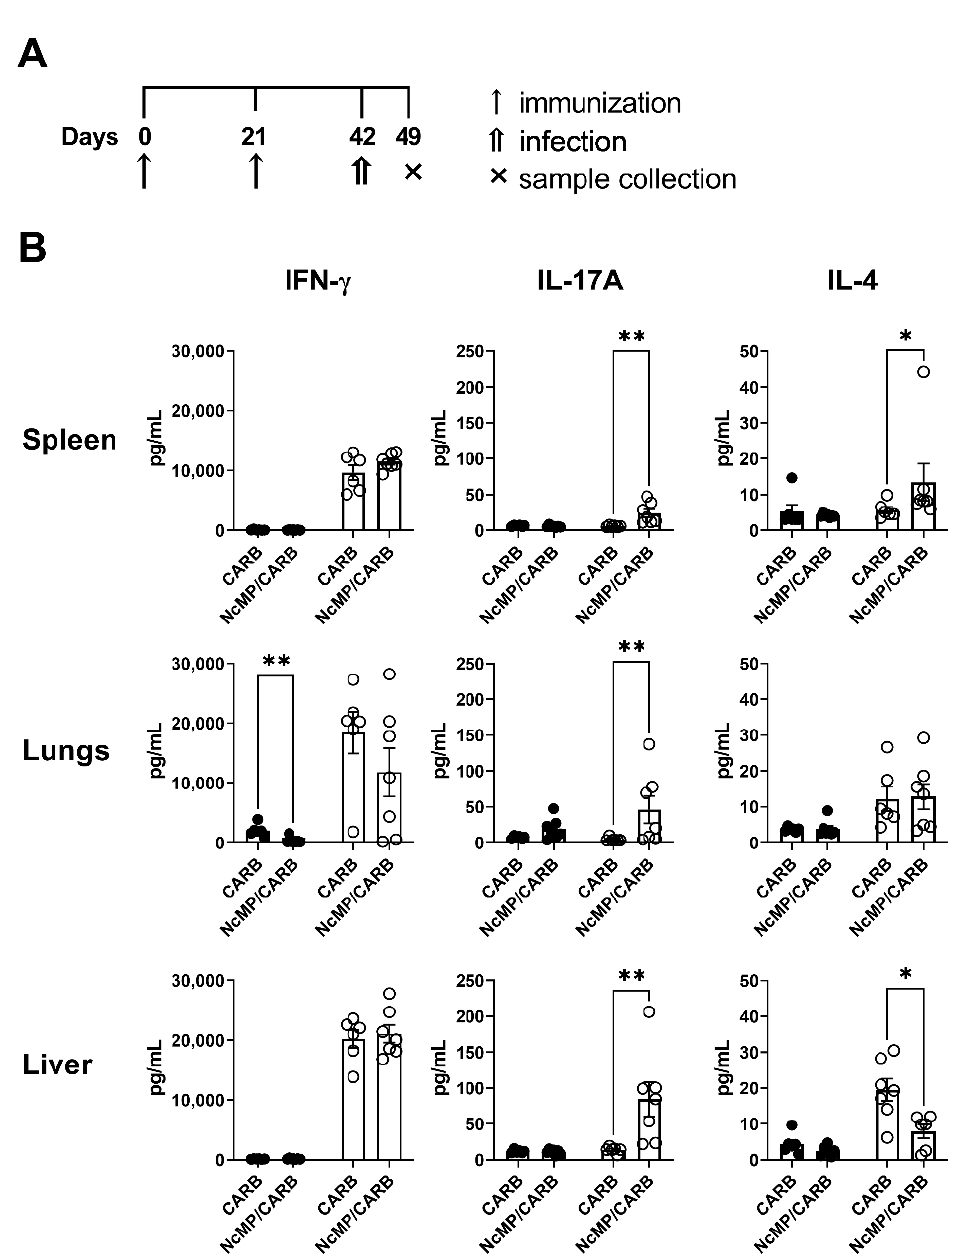
Figure 8. Analysis of cytokine production. Timeline of immunization, infection and sample collection ( A ). IFN- γ , IL-4 and IL-17A concentration ( B ) in the supernatants of splenocyte cell cultures unstimulated (closed symbols) or stimulated (open symbols) for 3 days with N. caninum whole parasite antigen sonicates. Cells were isolated from the spleen, lungs and liver of mice from NcMP/CARB or control CARB groups, as indicated, 7 days after the i.p. challenge with 1 × 10 7 N. caninum tachyzoites. Each symbol (black and white circles) represents an individual mouse; bars correspond to the mean value in each group ± SEM. Results are representative of two independent experiments that yielded concordant results ( n = 6 group; * p < 0.05; ** p < 0.01, Mann – Whitney).